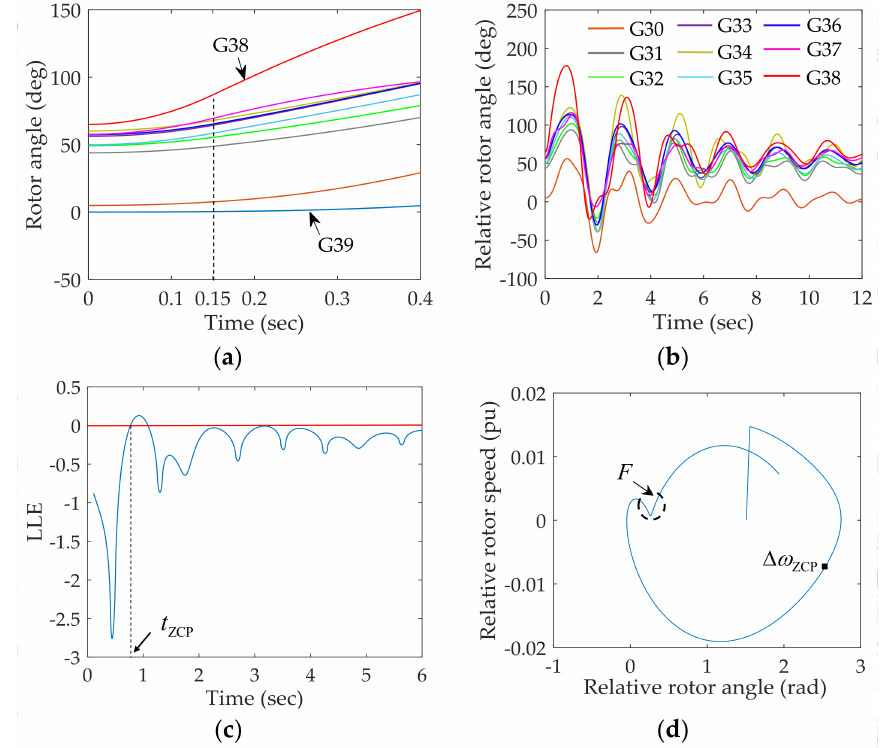
Figure 6. Simulation results for Case 1: ( a ) Rotor angle curves of generators after fault; ( b ) relative rotor angle curves after fault (G39 is the reference generator); ( c ) LLE–time curves; ( d ) phase-plane trajectories after clearing the